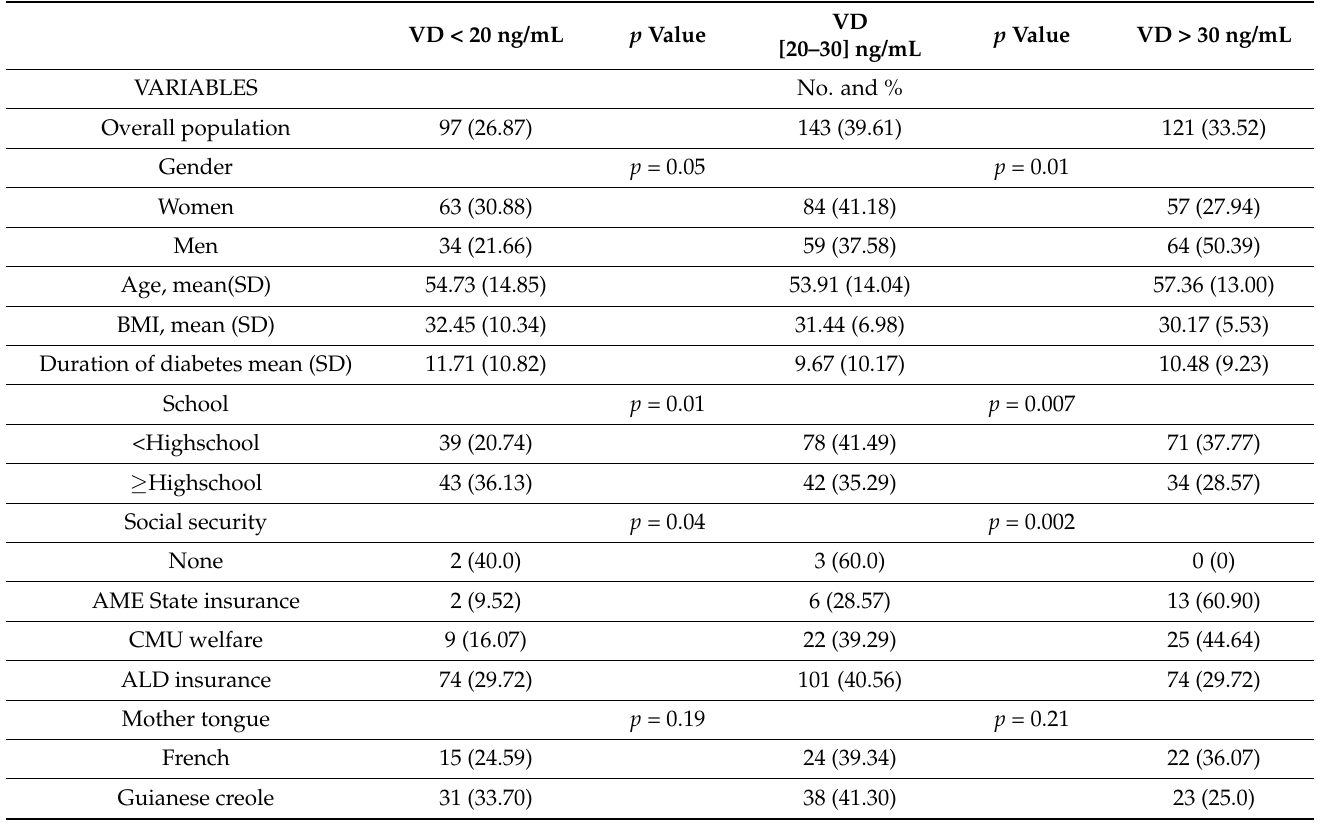
Table 1. Characteristics of the sample population according to vitamin D (vitamin D) level regardless of diabetes type, expressed as number “No.” of patients and percentages (%); age, BMI and duration of diabetes expressed as mean and standard deviation